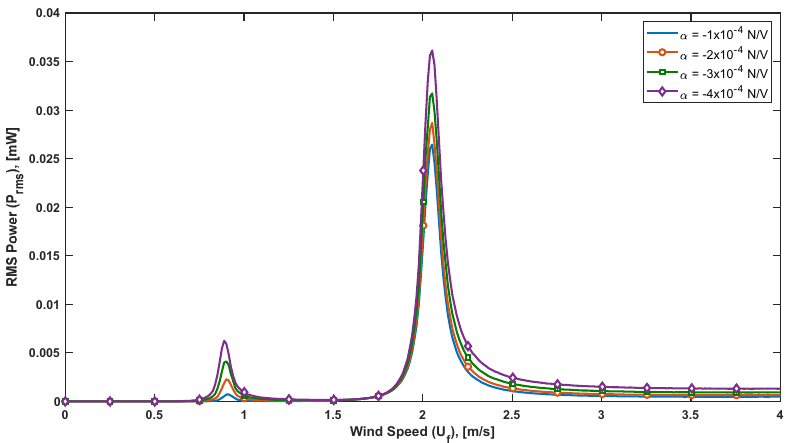
Figure 13. The effect coupling coefficient ( 𝛼 ) on the harvester output power. Although the power decreases as the coupling coefficient is increasing, the power is, in fact, increasing beyond the second fundamental frequency. For instance, at a coupling factor ( 𝜃 (cid:3030) ) of 1 N/A, the harvested power beyond the second natural frequency increases slightly as the wind speed increases. In contrast, at a higher coupling factor of 5 N/A, the increase in the harvested power is much larger than that of a low coupling coefficient (i.e., it is five times larger at a wind speed of 8 m/s). This increase in harvesting power beyond the second natural frequency (at higher wind speed) has been reported by many research- ers [33]. It is associated with the nature of the electromagnetic circuit of the harvester pro- vided by Equation (22), in which the inductive impedance dominates at higher frequen- cies or wind speeds. One more advantage of increasing the EM coupling coefficient is the increase in the bandwidth of the harvester. At a fixed power output of 0.3 mW, the band- width of a harvester with a larger coupling coefficient is almost 2.5 times larger than that of the case with lower coupling.